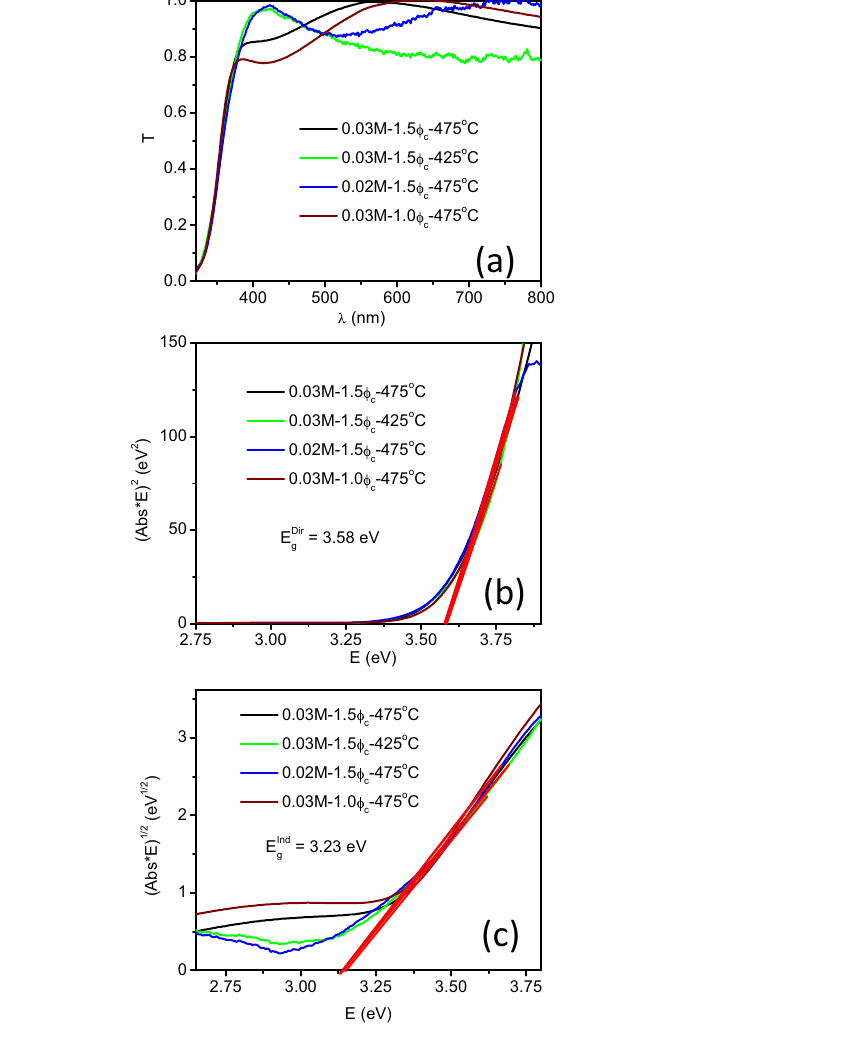
Figure 3. ( a ) Transmittance spectra and the corresponding Tauc plots for the direct ( b ) and indirect ( c ) gaps for the 0.03-HF-475, 0.03-HF-425, 0.02-HF-475, and 0.03-LF-475